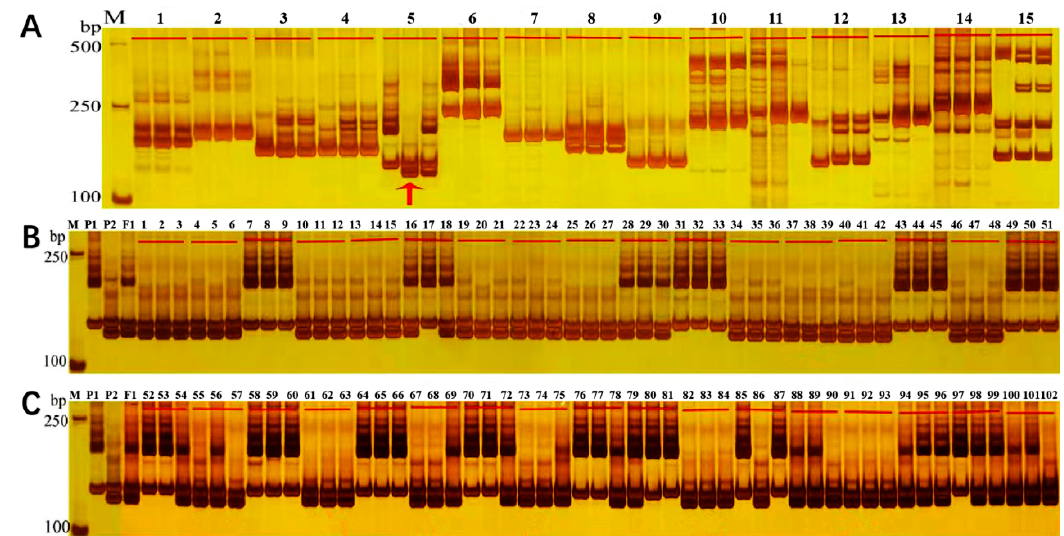
Figure 6. SSR primer screening and candidate gene verification. ( A ) Amplification of the SSR primers in parents and F 1 ; ( B , C ) SSR primer sequences validation of BjLMI1 gene. M: 2000 bp DNA ladder; P1: MN001; P2: MU056. The plant numbers of the F 4 inbred line were 1~3 to 100~102.